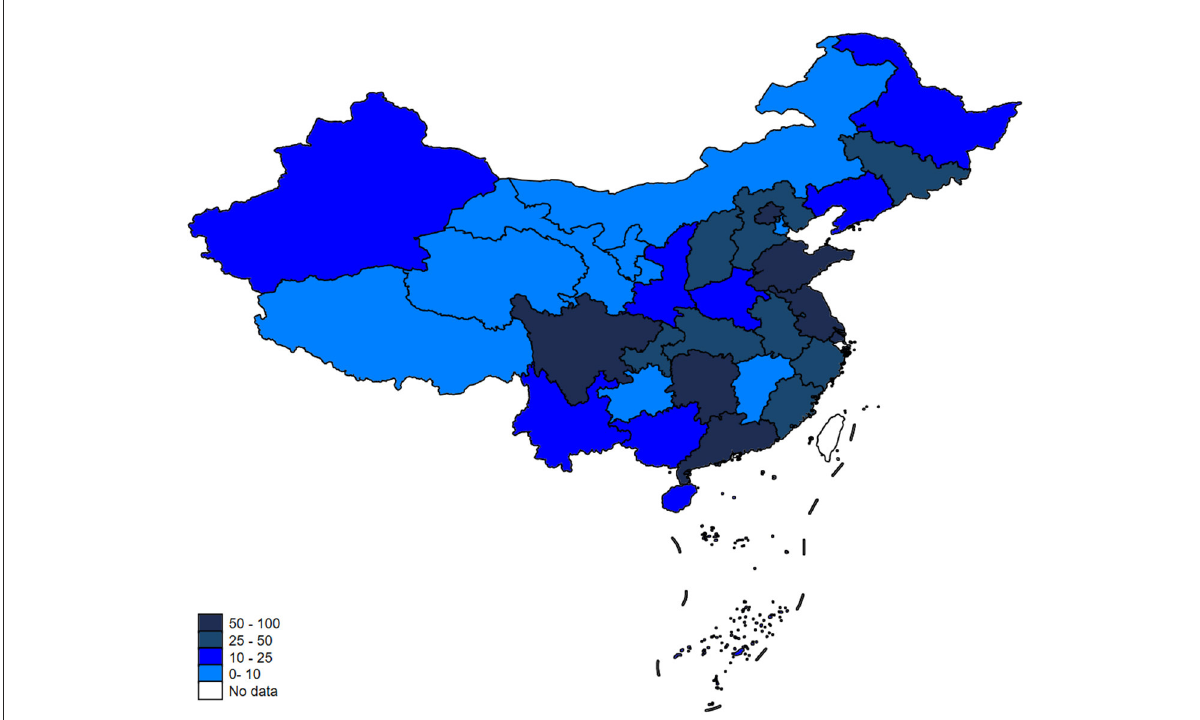
FIGURE2 Provincial distribution of the number of national air quality monitoring sites in